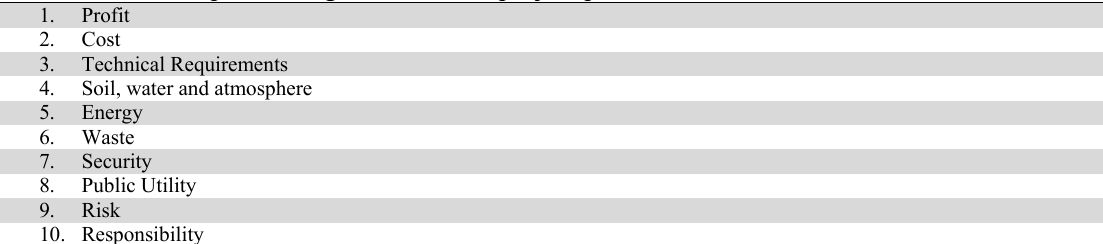
Effective criteria in prioritizing construction project